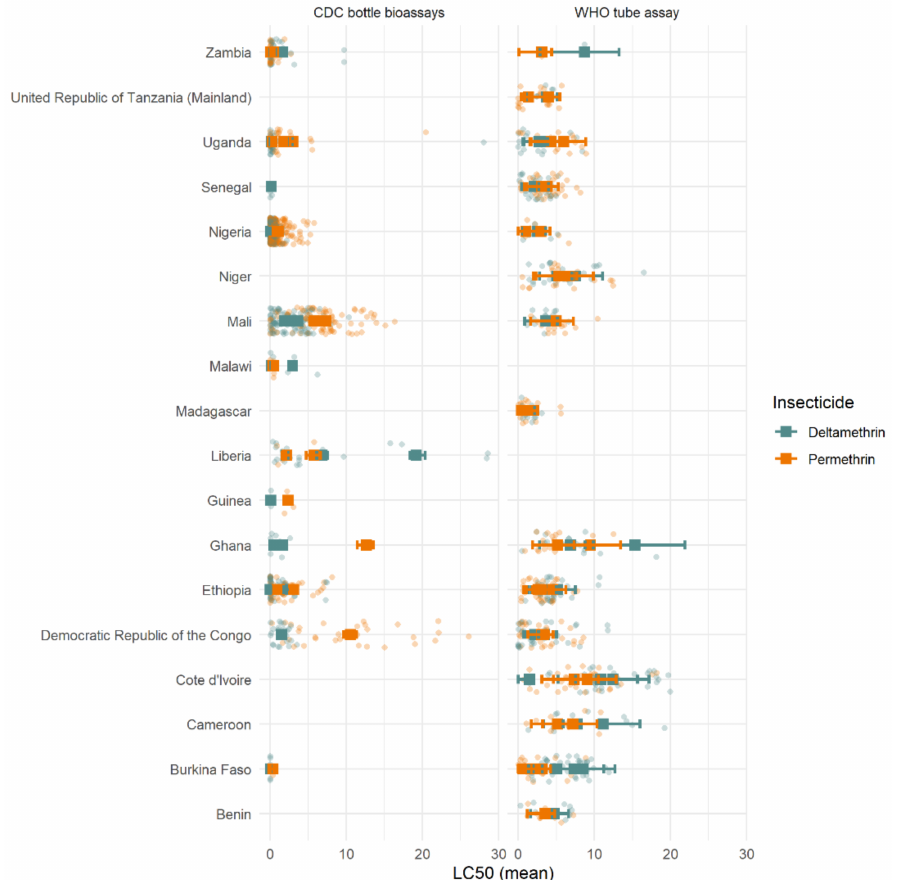
Figure 11. Estimated LC 50 values for each country and assay type. The solid squares represent the mean value per country with each individual intensity bioassay LC 50 value shown as the light points. Horizontal coloured lines indicate 95% credible intervals of the mean LC 50 estimates. The x-axis units are DD concentration 10 × , 20 × , and 30 ×